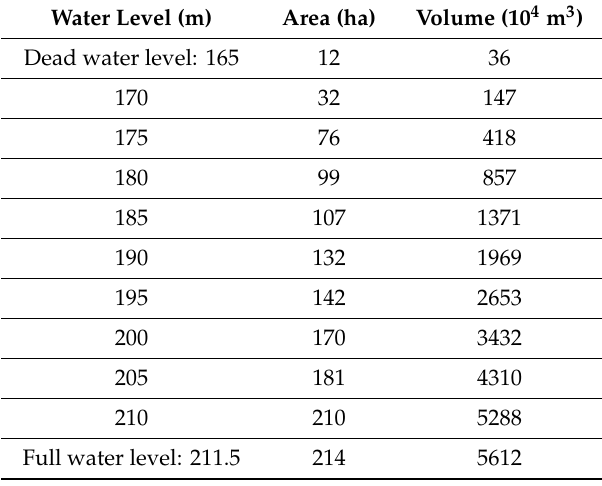
Table 1. Elevation-area-capacity relationship of Hushan